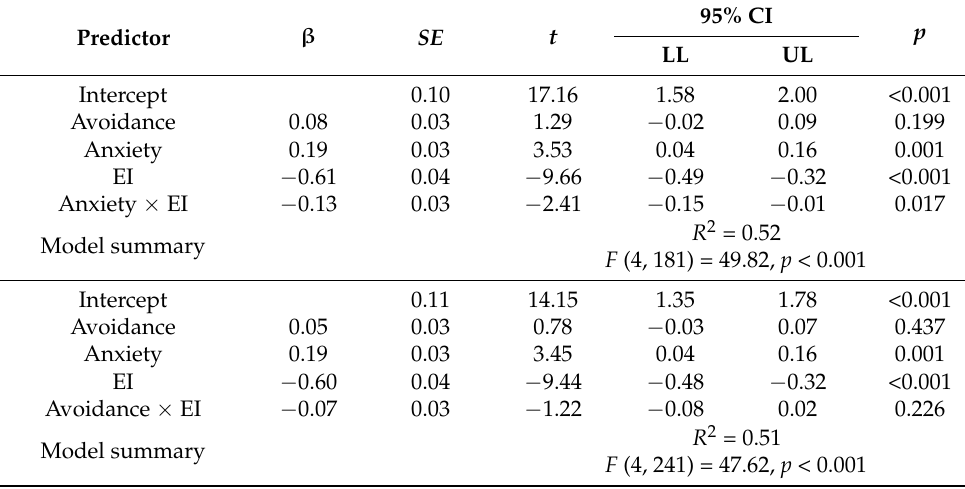
Table 8. Moderation analyses for Study